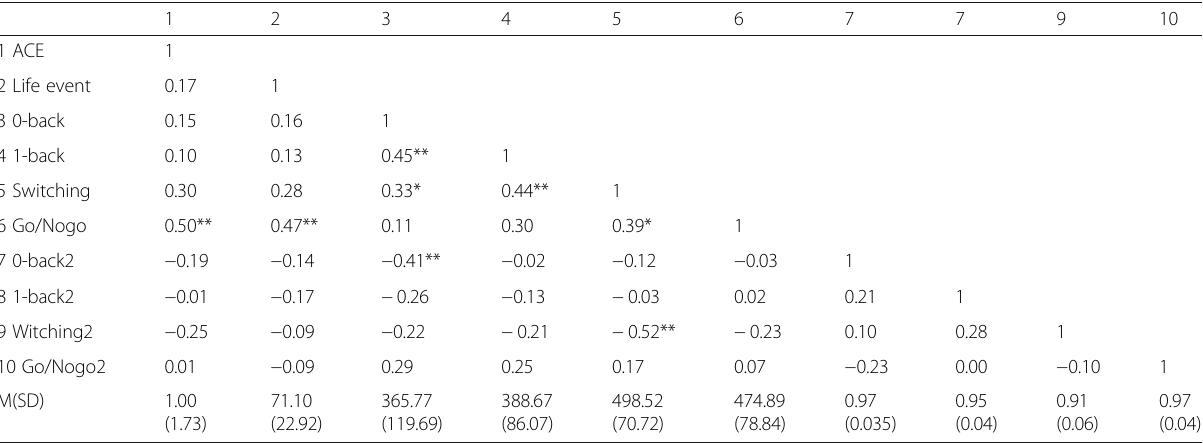
Table 4 The correlation analysis between ACEs, life events, and